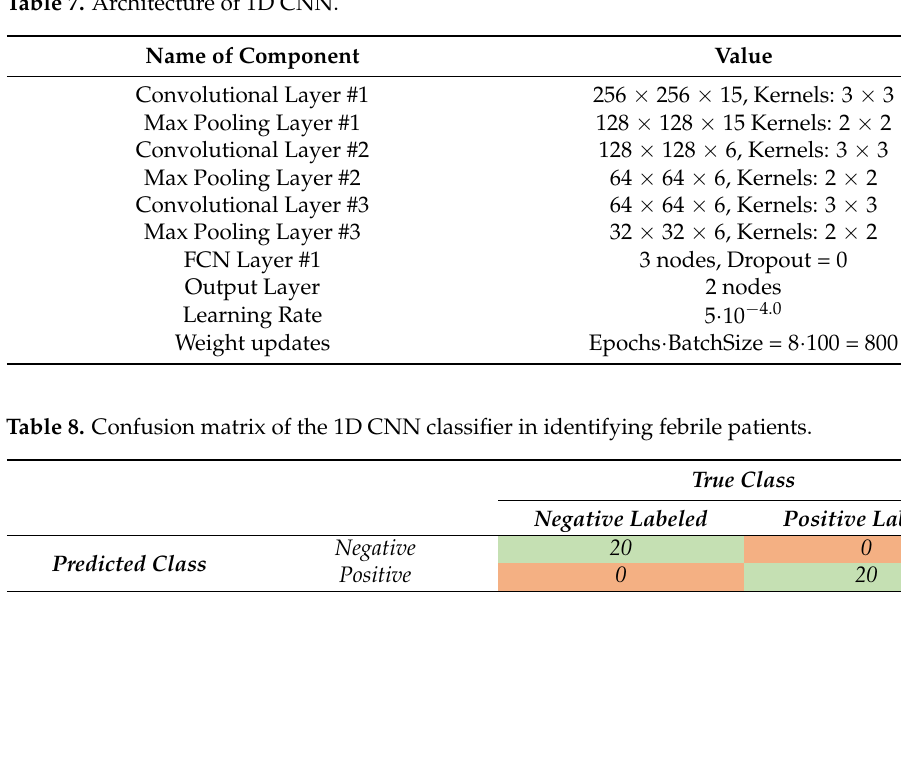
Table 7. Architecture of 1D CNN.